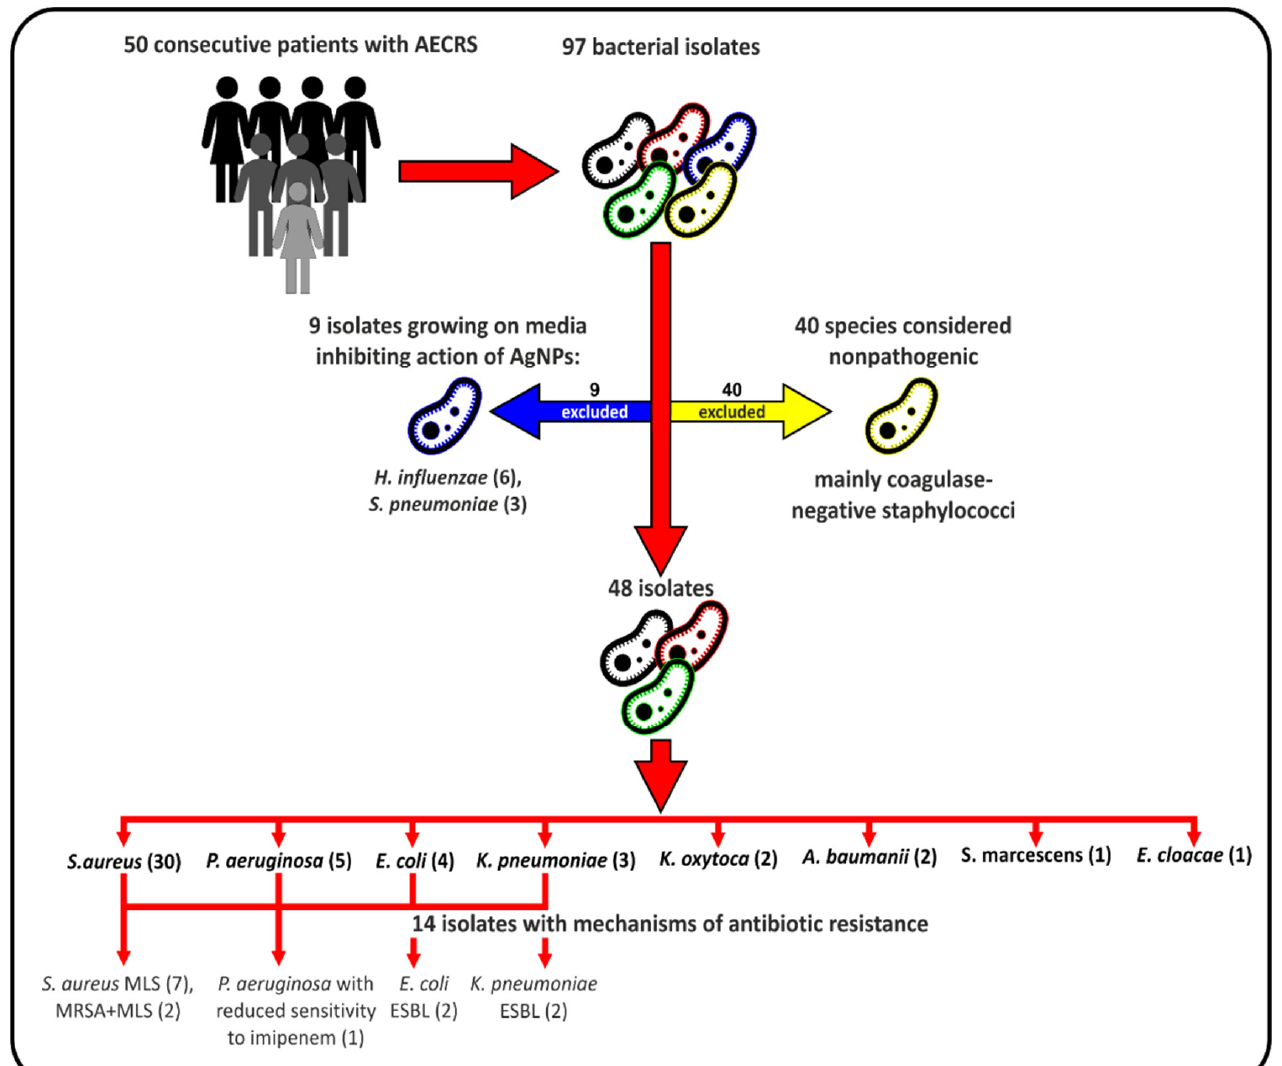
Figure 3. Flow chart detailing the election of bacterial isolates for the study.